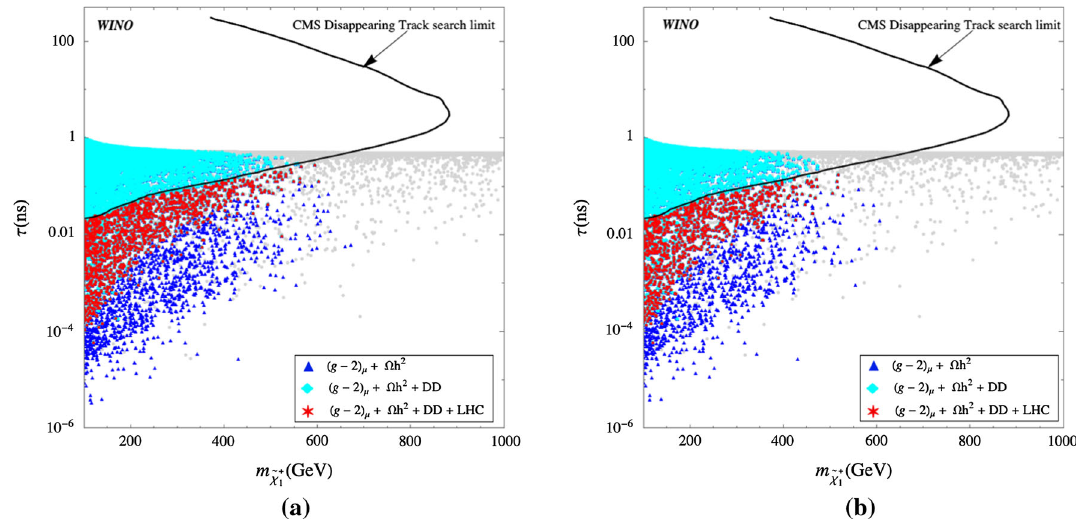
Fig. 7 The results of our wino parameter scan in the m ˜ χ ± – τ plane for current (left) and anticipated future limits (right) from ( g − 2 ) μ , where τ is 1 the lifetime of the chargino decaying to π ± ˜ χ 0 . The current limit from CMS [91] is shown as the black solid line. The color coding is as in Fig. 6 1